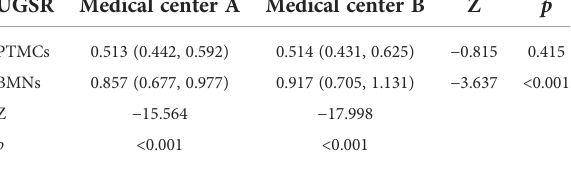
TABLE 2 Distribution of UGSR in both medical centers. UGSR